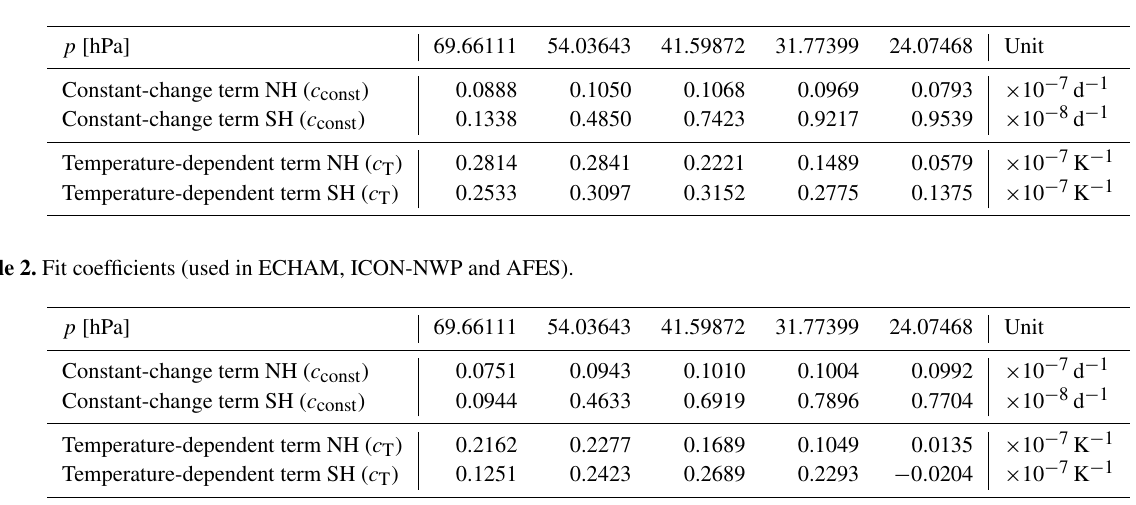
Table 1. Fit coefficients (current version). For a version with error bars, see Table S1 in the Supplement.